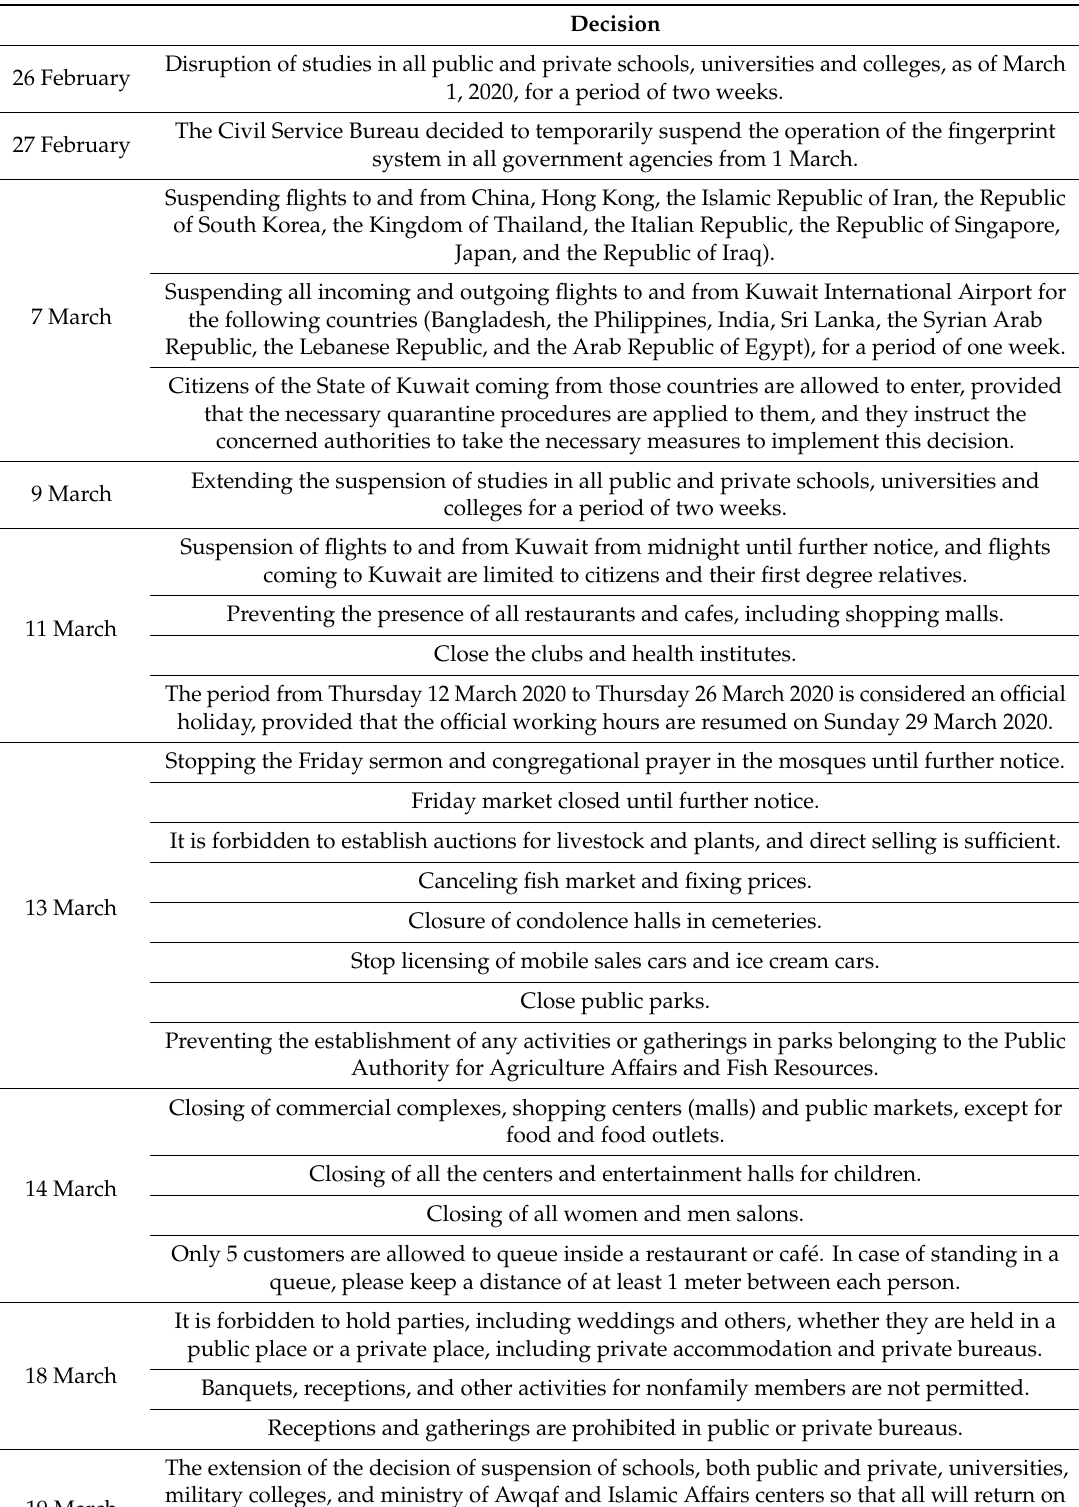
Table 2. The rigorous containments and orders taken by Kuwait Government.